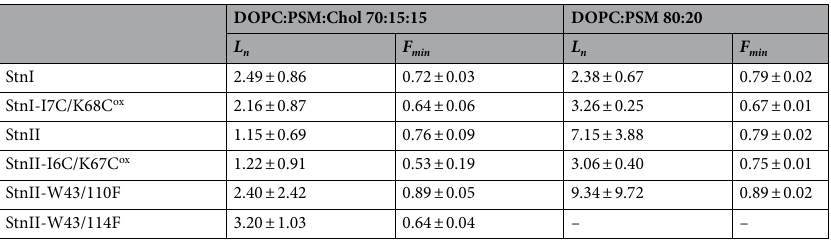
Table 2. PC-lipid contacts. Number of PC lipids ( L n ) in contact with the membrane inserted Trp residues of the indicated Stn variants in membranes with and without Chol. The value of the non-quenchable fluorescence ( F min ) is also indicated. Values are result ± SD, obtained by fitting